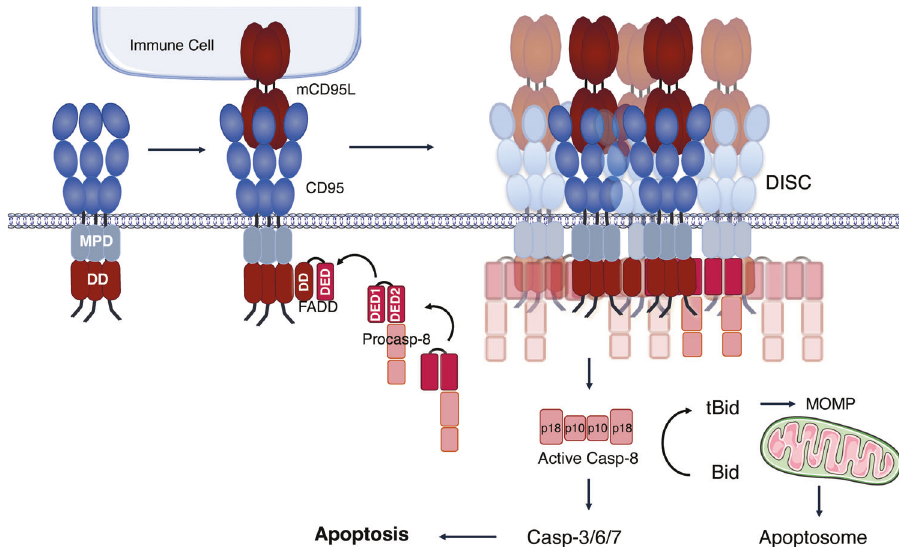
Fig. 2 CD95-dependent apoptotic signaling. Representation of the CD95-mediated conventional or apoptotic pathway. The interaction between CD95 and its membrane-bound ligand mCD95L, triggers the recruitment of the adaptor protein FADD, which then recruits procaspase-8 generating the oligomerized DISC. The oligomerisation and auto-cleavage of procaspase-8 into its active form induces then the activation of the effector caspases-3, -6, -7 leading to apoptosis. Active caspase-8 is also able to cleave Bid, generating t-Bid that promotes Mitochondrial outer membrane permeabilization (MOMP) and thus the apoptosome-mediated effector caspase